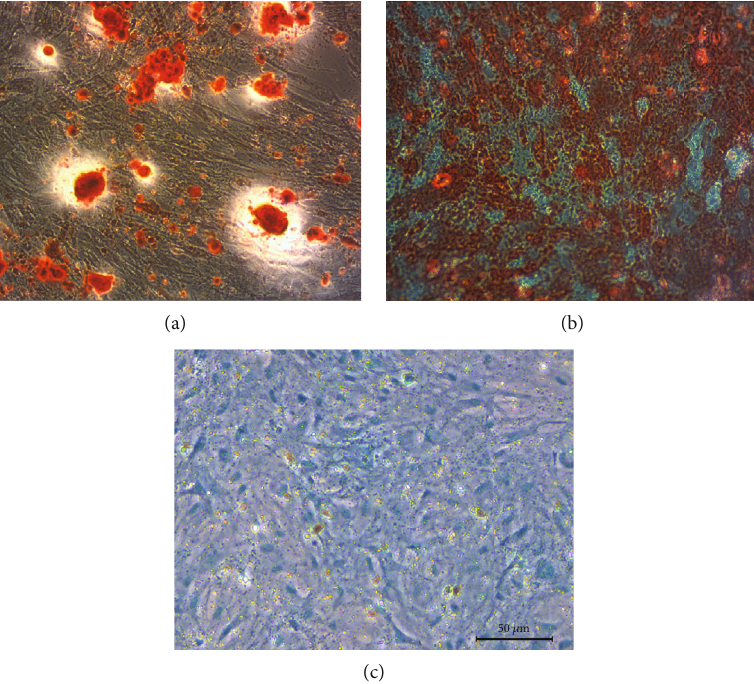
Figure 3: Representative images from alizarin red (a), oil red O (b), and alcian blue (c) staining to detect the osteogenic, adipogenic, and chondrogenic di ff erentiation abilities of passage 3 cells.